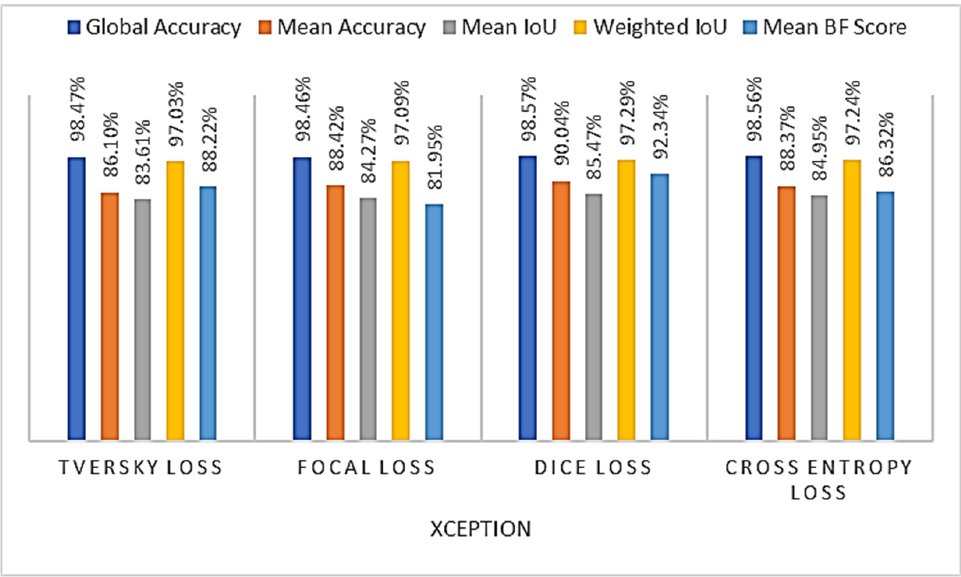
Figure 5. The overall metrics were gathered using different loss functions with Deeplabv3+ with Xception as the backbone.